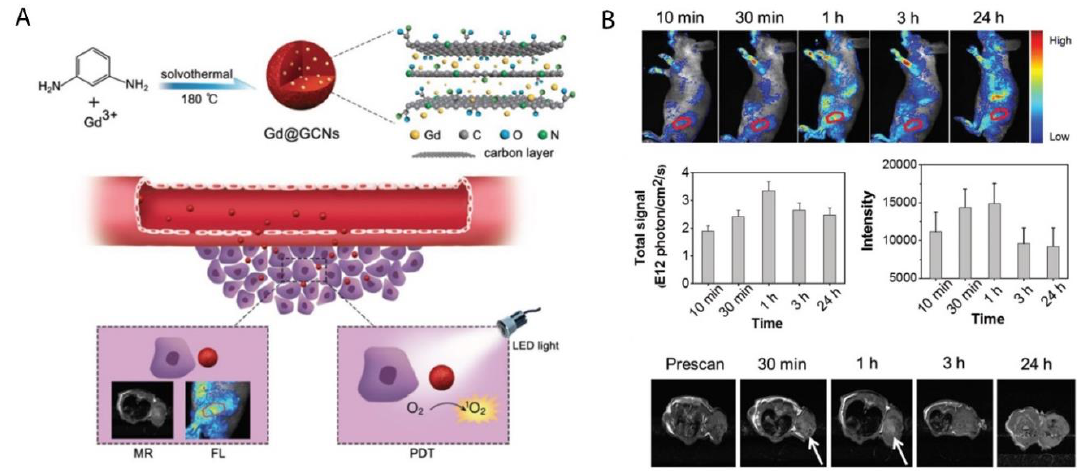
Figure 3. ( A ) Preparation of Gd@GCNs nanoplatform for imaging-guided phototherapy in solid tumors, ( B ) In vivo fluorescence images acquired from tumor-bearing nude mice after intravenous injection of Gd@GCNs at different time intervals, noting significant tumor shrinkage over time after PDT treatment. Reprinted with permission from ref. [116]. Copyright 2018 Wiley Online Library.